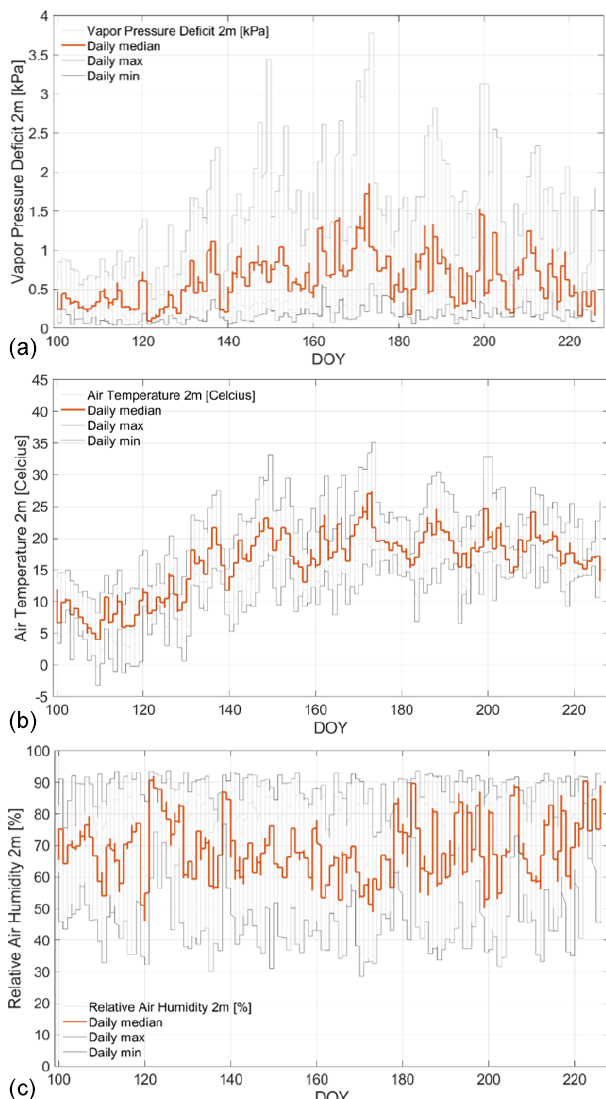
Figure 4. Calculated vapor pressure deficit (VPD [kPa]) at 2[m] height (a) from measurements of air temperature ( T [ ◦ K]) (b) and relative humidity (RH[%]) (c) using Eq. (4) in the growing period of 2017 along days of year (DOY) in 2017 at the winter wheat field in Selhausen, Germany. Colored and gray curves indicate daily me- dian, minimum, and maximum of measurements and